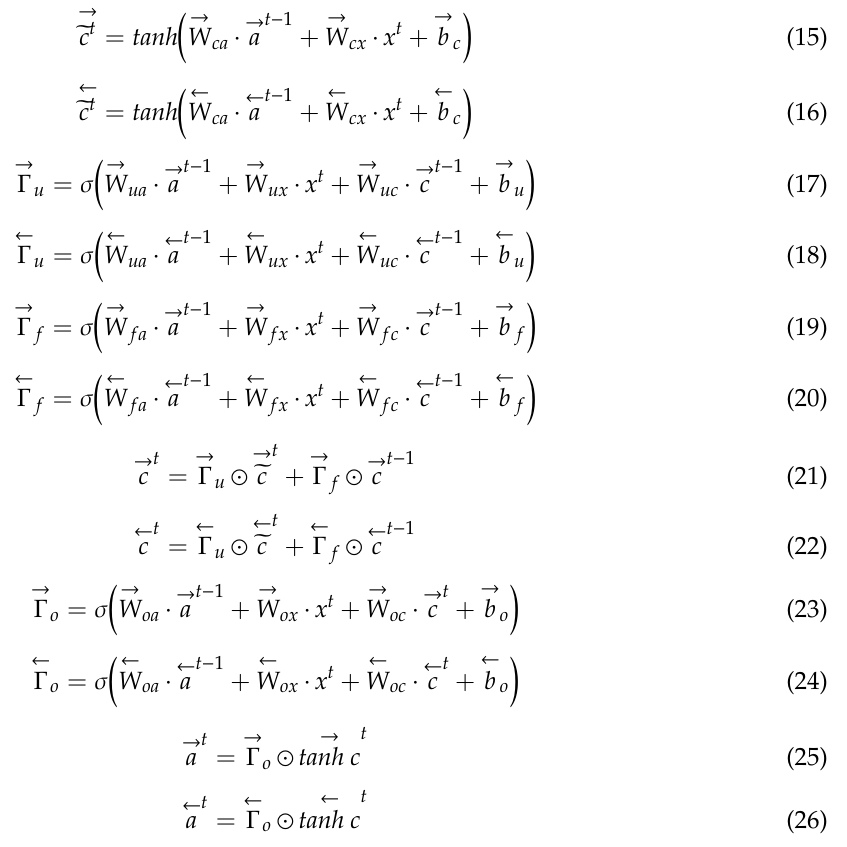
Figure 5. The two-layer Bidirectional Recurrent Neural Network. The outputs of the two corresponding LSTM units are added up in the first layer and sent to the second layer.